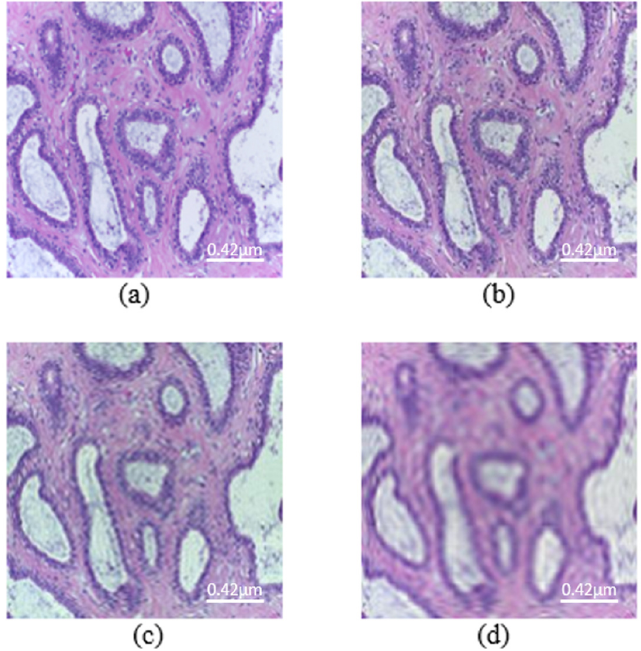
Figure 2. Images from the histopathological dataset (scale bar – 0.42 μ m). ( a ) Original image. Mb-Ada with order, ( b ) 200, ( c ) 120, ( d ) 50.